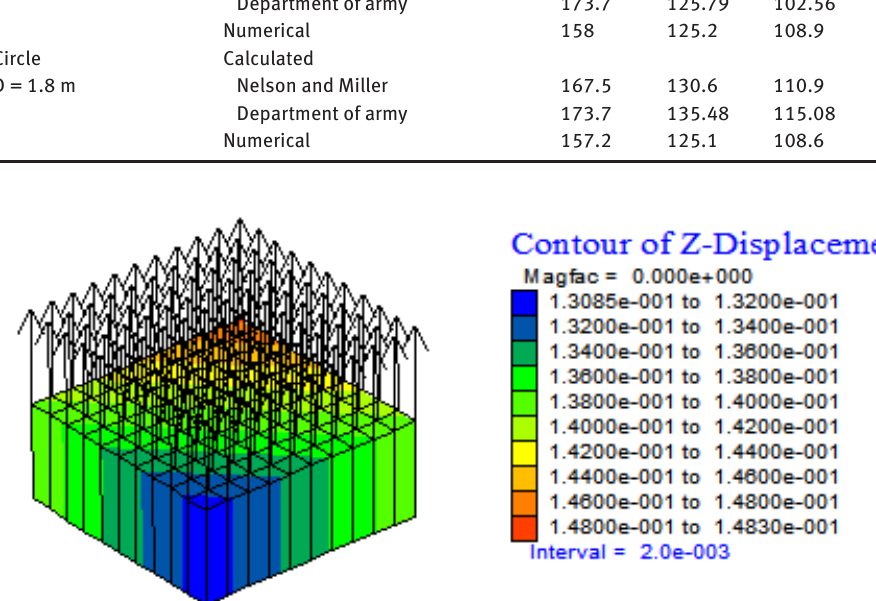
=100 kPa. 0 𝜎𝜎𝜎𝜎 0 = 100 kPa